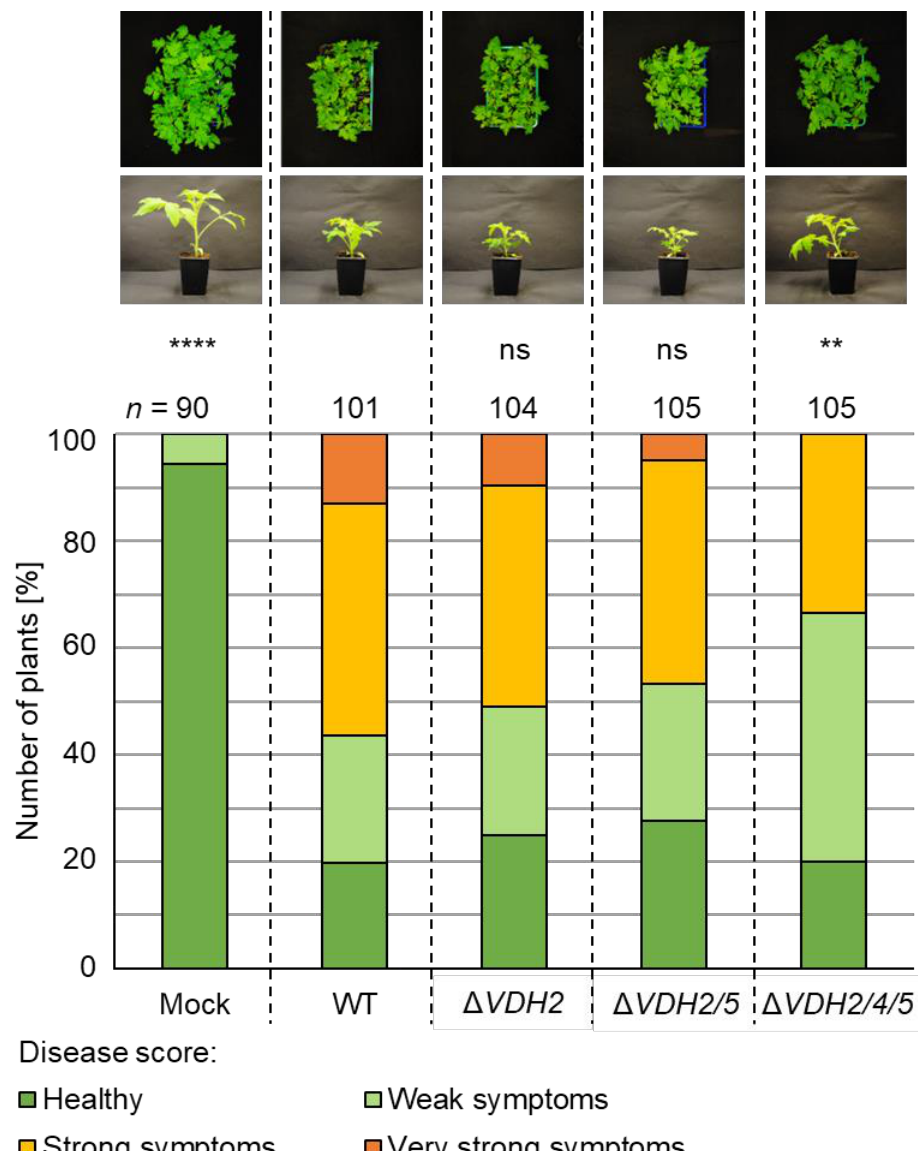
Figure 7. The enhanced triggering of disease symptoms in the presence of both intact VDH4 and VDH5 genes is independent of Vdh2. Tomato seedlings (ten-day-old) were infected by spores of JR2 wild-type (WT) or VDH2 deletion ( ∆ VDH2 ), VDH2/5 double deletion ( ∆ VDH2/5 ), and VDH2/4/5 triple deletion ( ∆ VDH2/4/5 ) strains via root-dipping. Water-treated plants (mock) served as controls. Plants were incubated in a climate chamber at 16 h: 8 h light: dark at 22–25 ◦ C. A general disease score was determined at 21 days after inoculation based on plant height, length of longest leaf, and plant weight. The experiment was conducted four independent times ( n = number of treated plants).